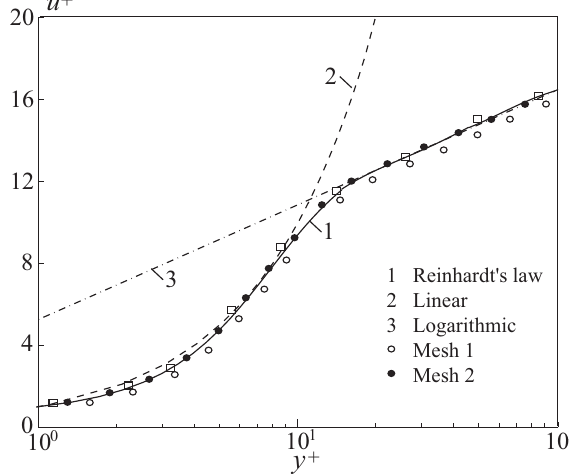
Figure 3. Velocity profiles in the boundary layer.